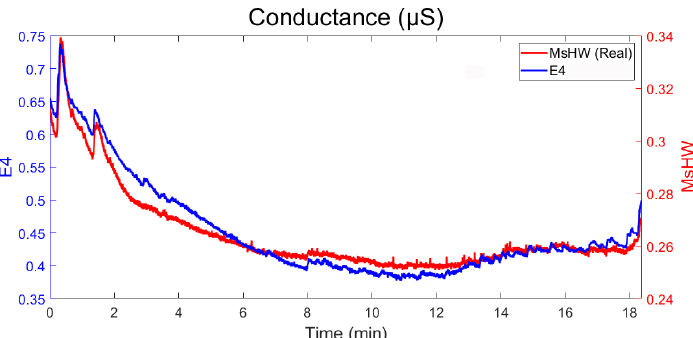
Figure 20. Comparison of measurement of skin response conductance using MsWH and E4 over the same subject. Blue line (left axis): E4 measurement ( µ S). Red line (right axis): MsWH measure- ment ( µ